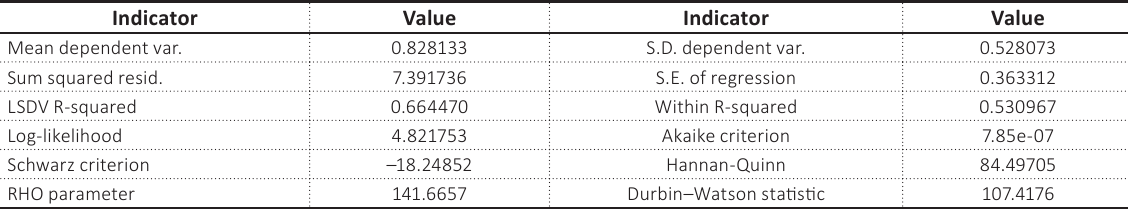
Table 10. Model 4 (EBITM). FEM (robust standard errors), using the observations